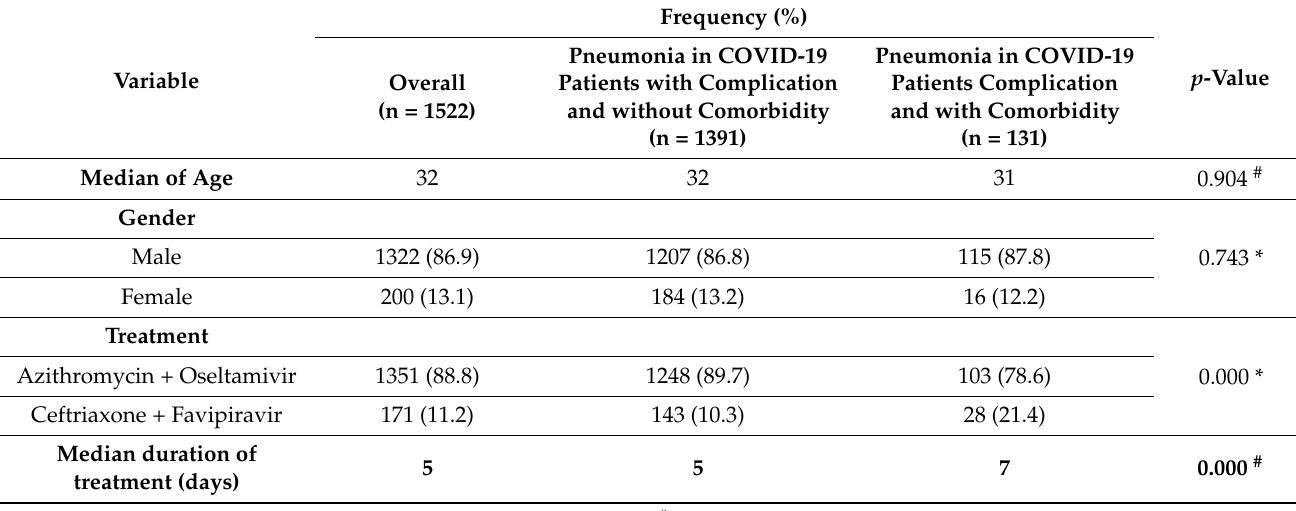
Table 1. Correlation between Pneumonia COVID-19 complication with and without comorbidity with the socio- demographics, treatment given and duration of